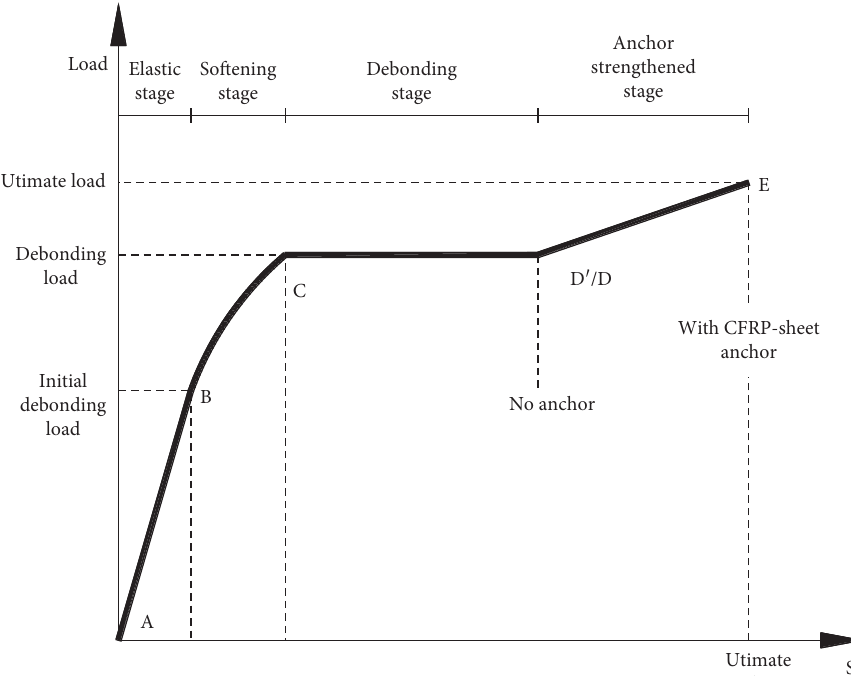
Figure 7: Theoretical load-slip curve of no anchor and anchorage